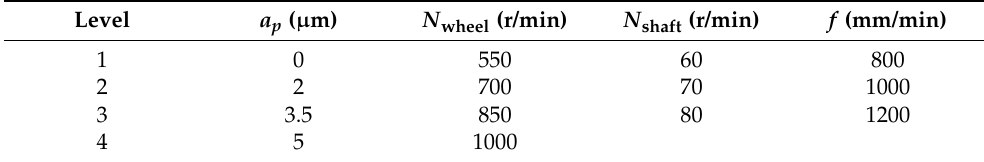
Table 1. Grinding parameters of the full factor